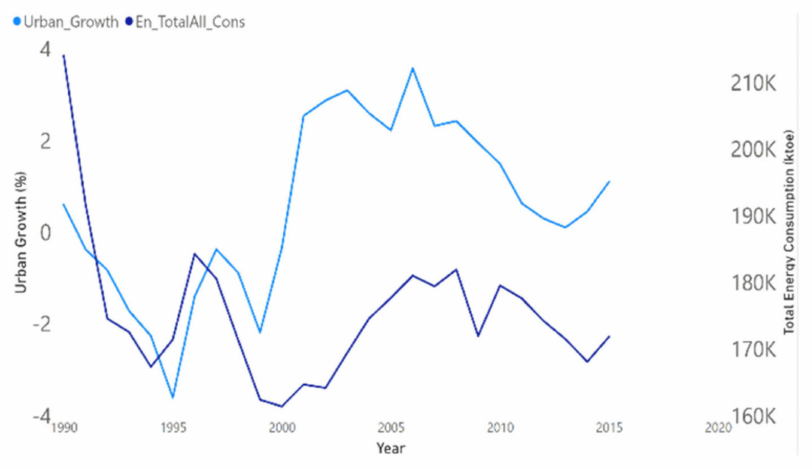
Figure 6. Urban population growth and energy